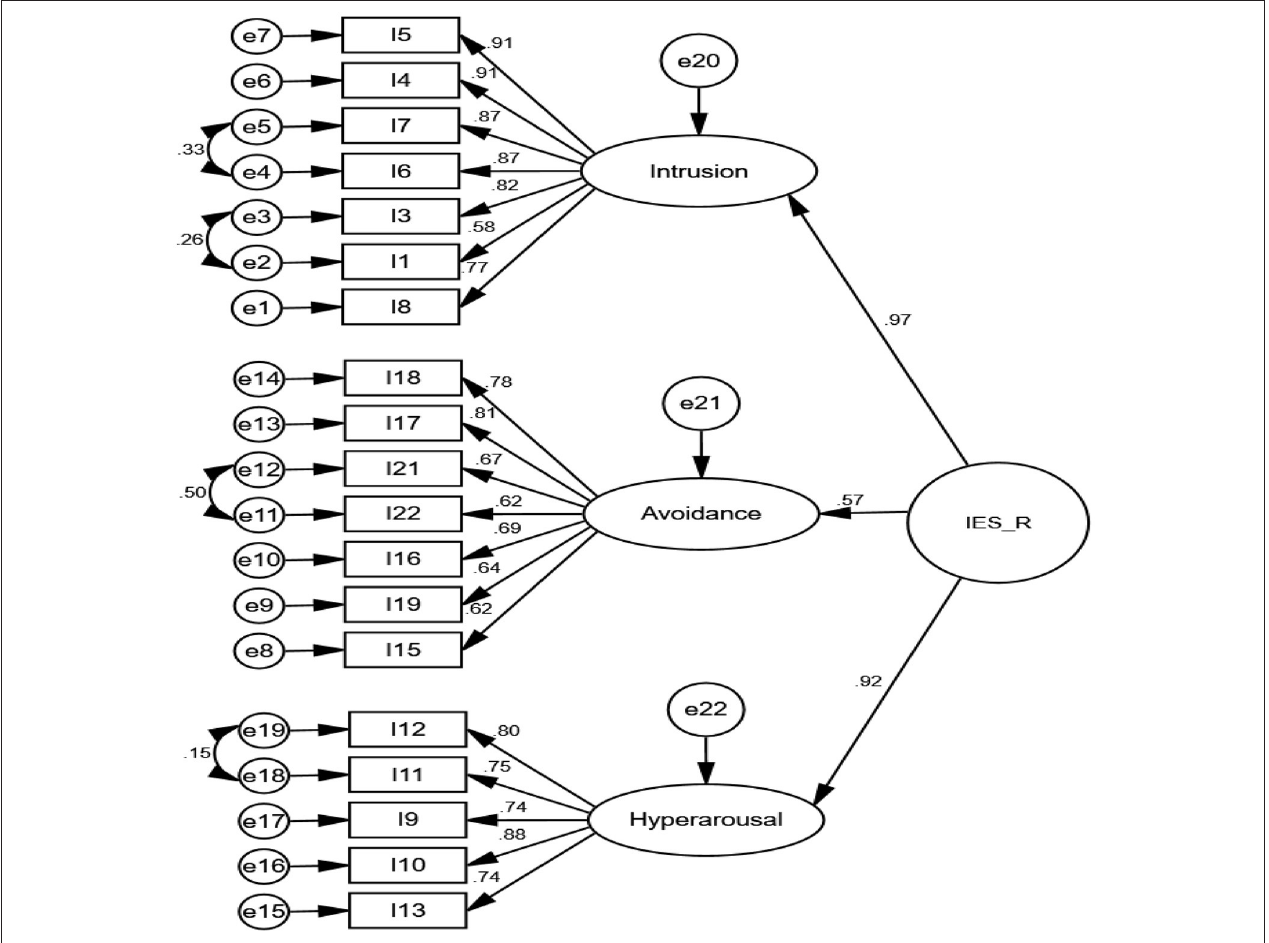
FIGURE 4 | Second—order CFA of IES-R ( n